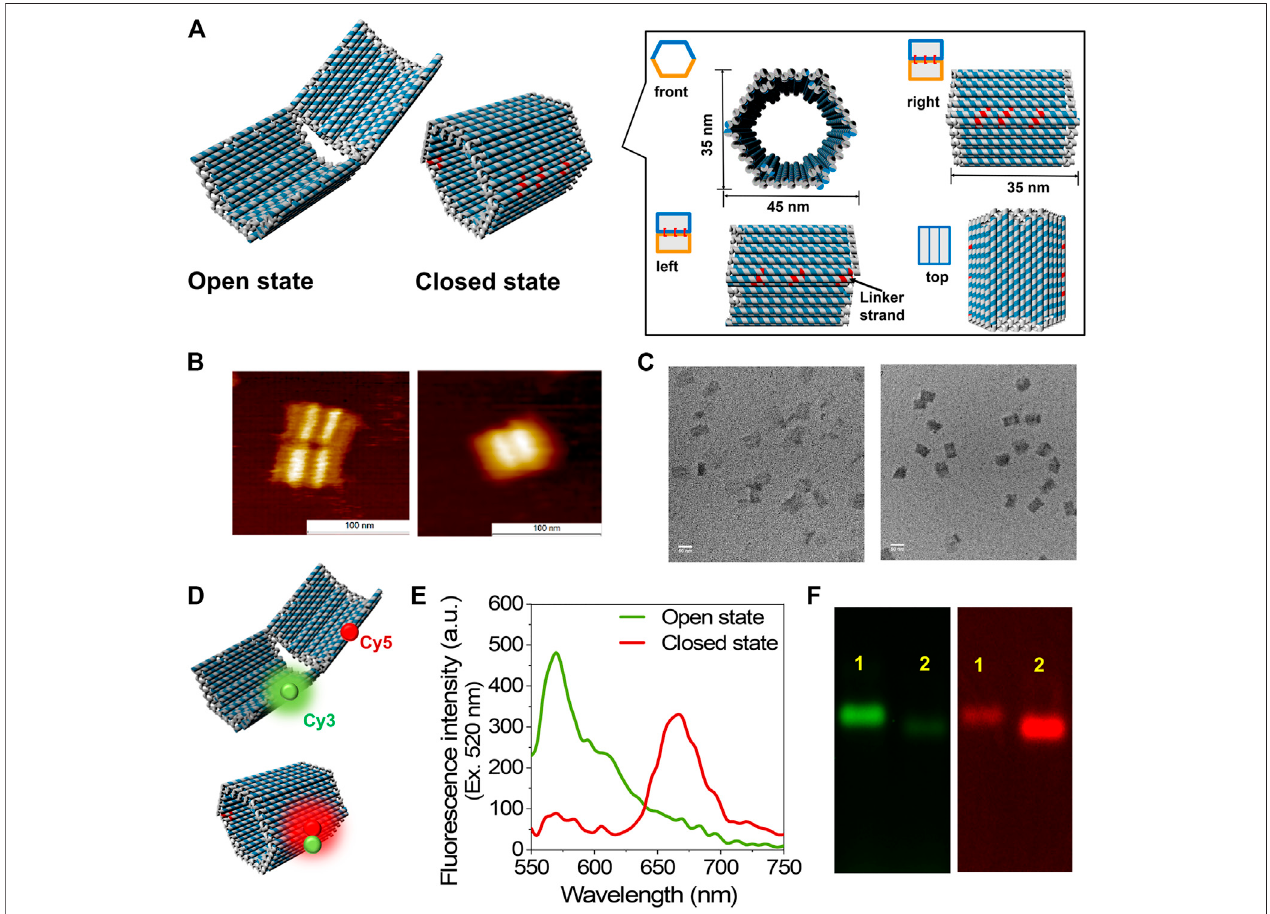
FIGURE 1 | Construction and characterization of DNA scaffold. (A) The scheme of DNA scaffold in open and closed states; the dimensions and different views of closed state were shown in the box. The staple strands in red indicated the linker strands spanning and hybridizing with the two domains of DNA scaffold. (B) AFM characterization of DNA scaffolds, left: open state; right: closed state, scale bar: 100 nm. (C) TEM characterization of DNA scaffolds, left: open state; right: closed state, scalebar:50 nm. (D) ModelsillustratetheCy3andCy5attachmentpositionsonDNAscaffold. (E) Fluorescenceemission spectraofopenandclosedstates excited at 520 nm, conditions: 5 nM DNA scaffold was scanned in the buffer (pH 7.0) containing 40 mM Tris-HCl, 20 mM acetic acid, 12.5 mM MgCl 2 , and 0.002% Tween20. (F) AgarosegelelectrophoreticanalysisofDNAscaffolds. Left: Cy3channel( λ ex (cid:2) 532 nm, λ em (cid:2) 605 nm); right: FRETchannel( λ ex (cid:2) 532 nm, λ em (cid:2) 695 nm); Lane 1: Open state (HPO); Lane 2: Closed state (HPC). Agarosegel electrophoresis conditions: 1% agarose gel in 1 × TAE (pH8.0) containing 12.5 mM MgCl 2 at 50 V for 6